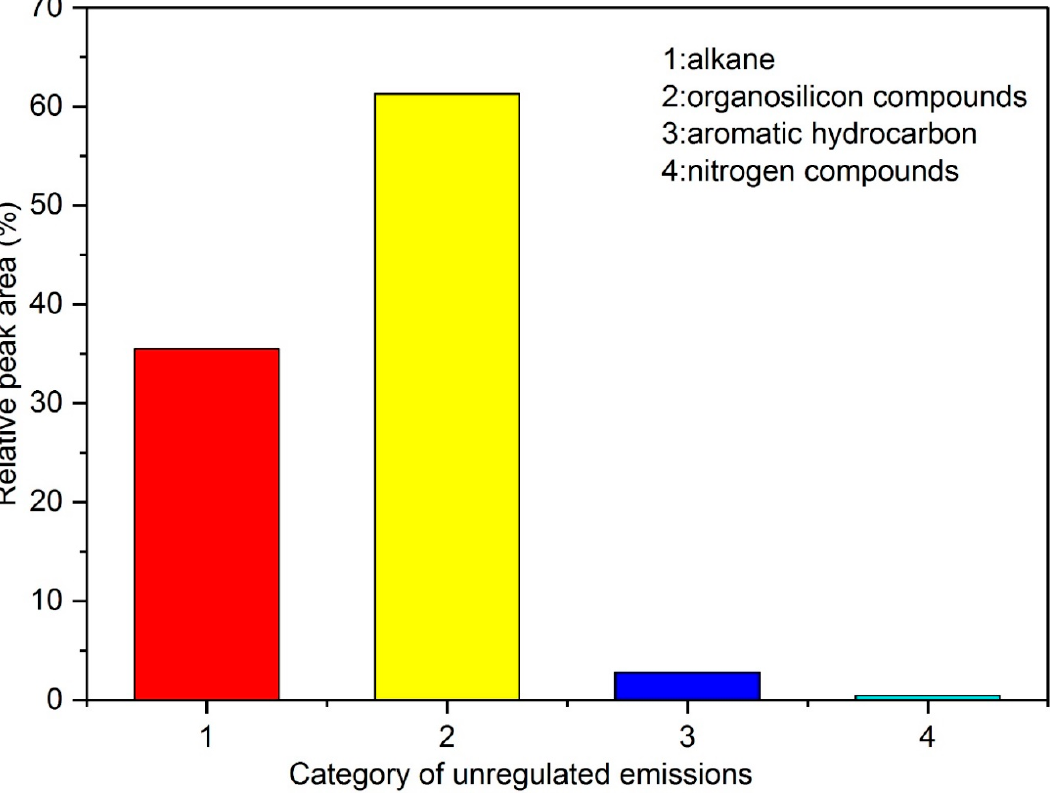
Figure 8. Relative concentration of unregulated emissions absorbed by absorption liquid in conventional diesel combustion.